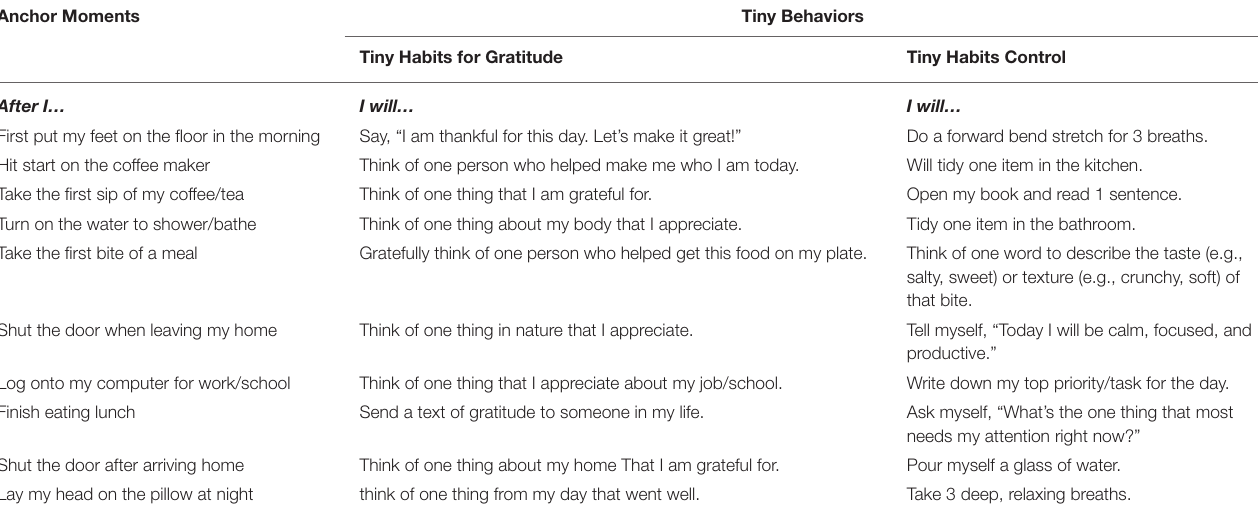
TABLE 1 | Tiny Habits ® recipes for the Tiny Habits for gratitude and Tiny Habits control groups. Anchor